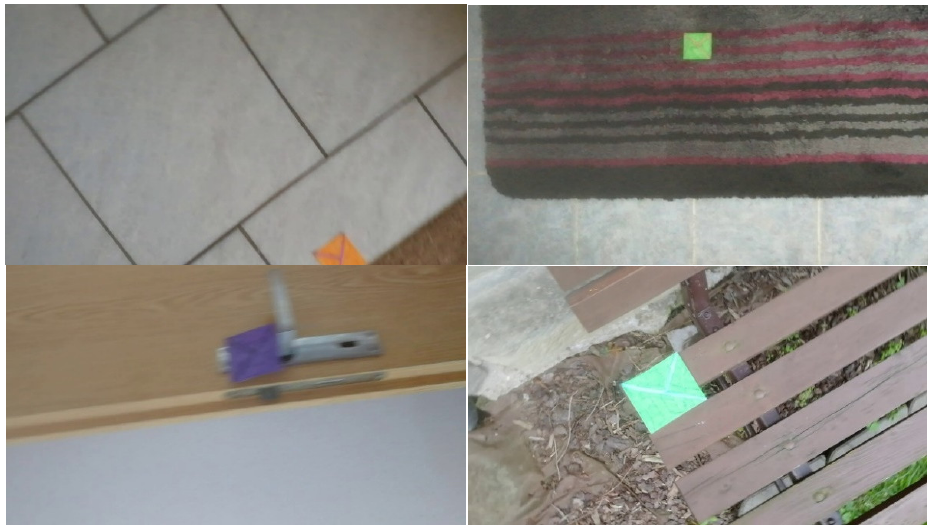
Figure 22. The four false negative cases with 0.3 detection probability threshold out of the 55 test images. The top two images are detected if detection probability threshold is set to 0.2.